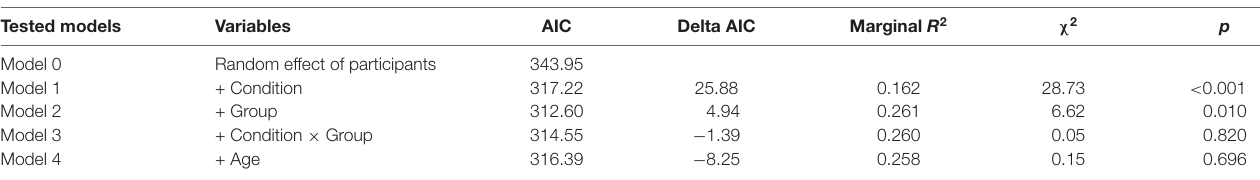
TABLE 5 | Comparison between models predicting the subjective experience of embodiment over the rubber hand. Tested